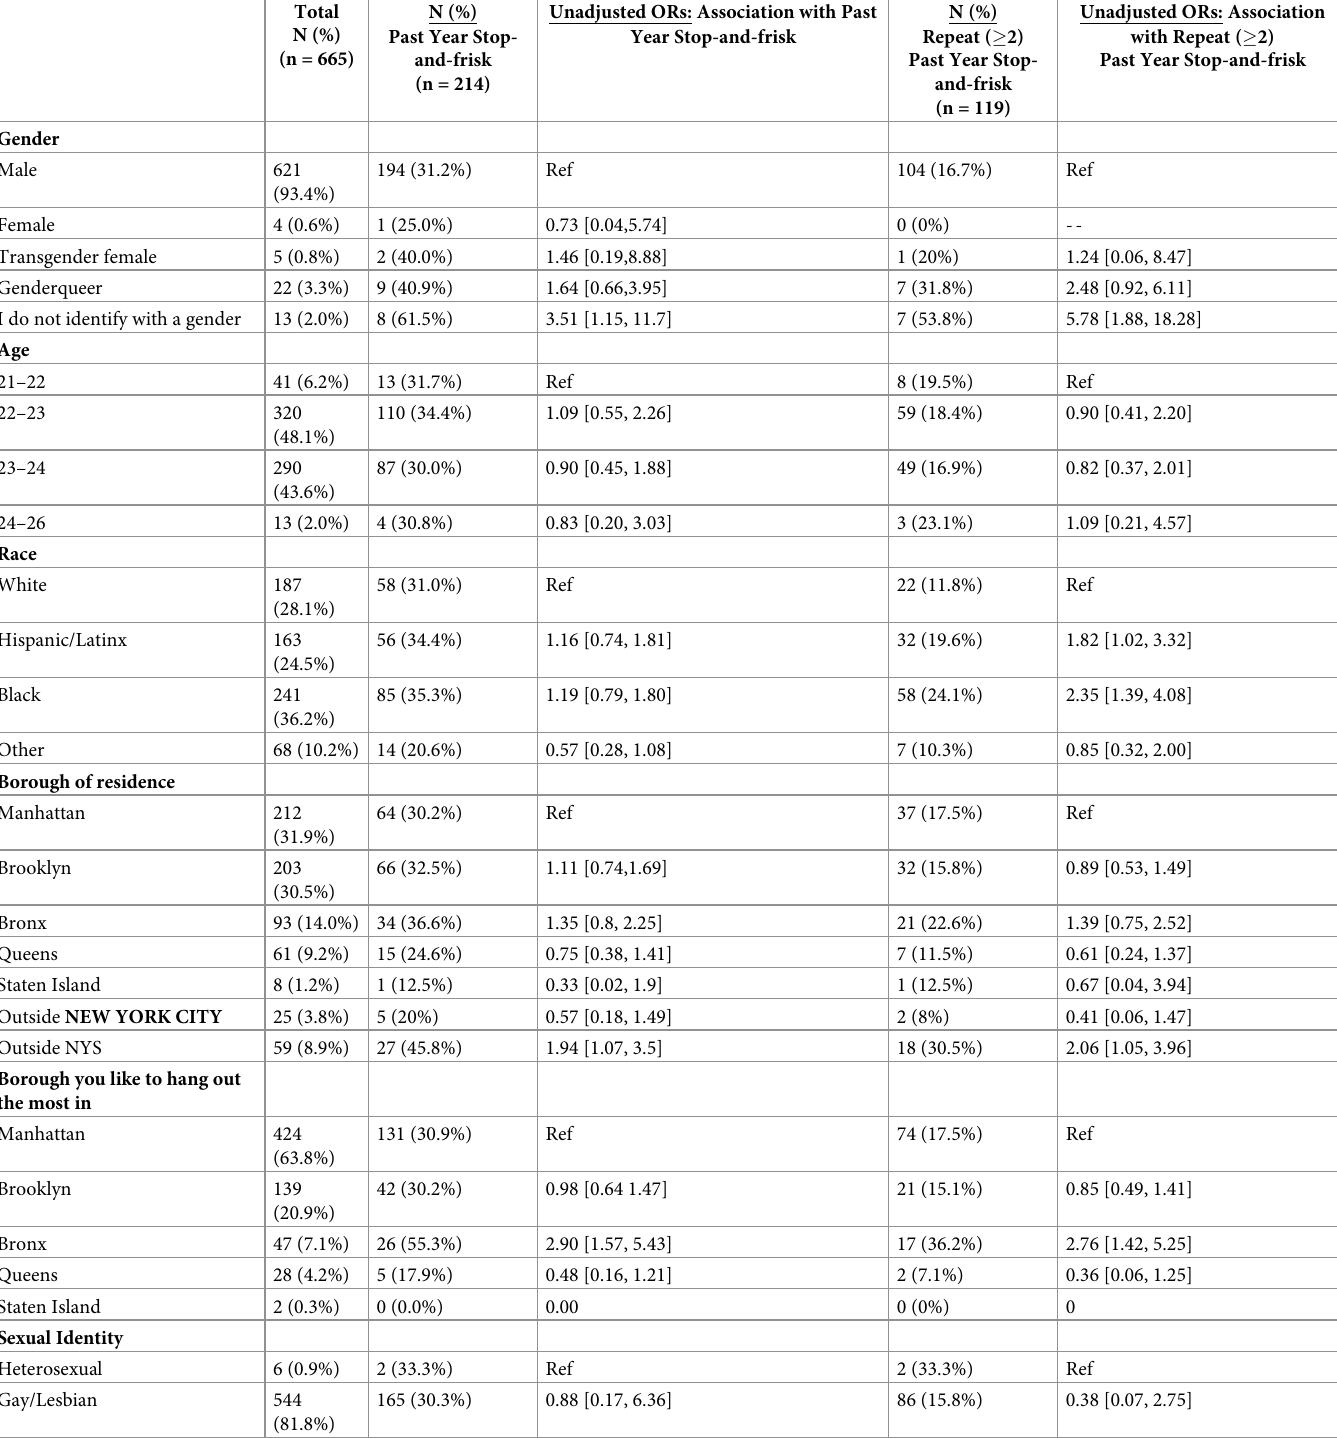
Table 1. Odds ratios (ORs) and 95% confidence intervals (CIs) for associations between participant socio-demographic, psychosocial, and behavioral factors and past year stop-and-frisk at cohort baseline in